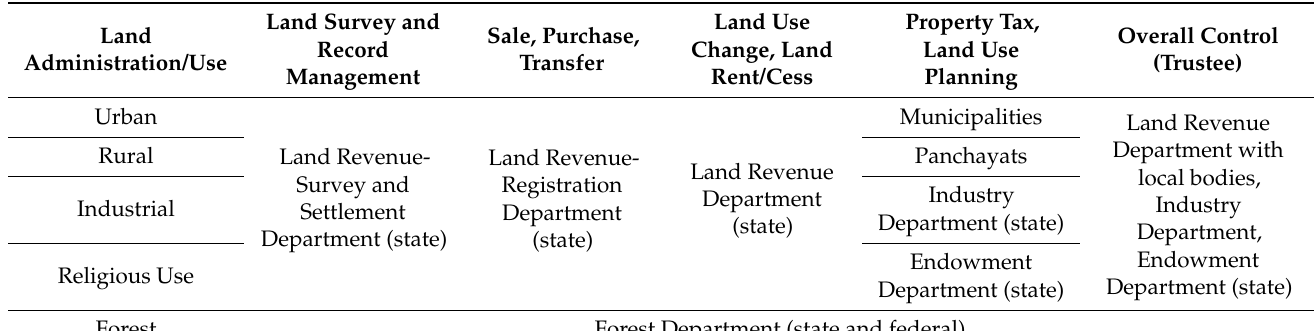
Table 2. Land administration structure in